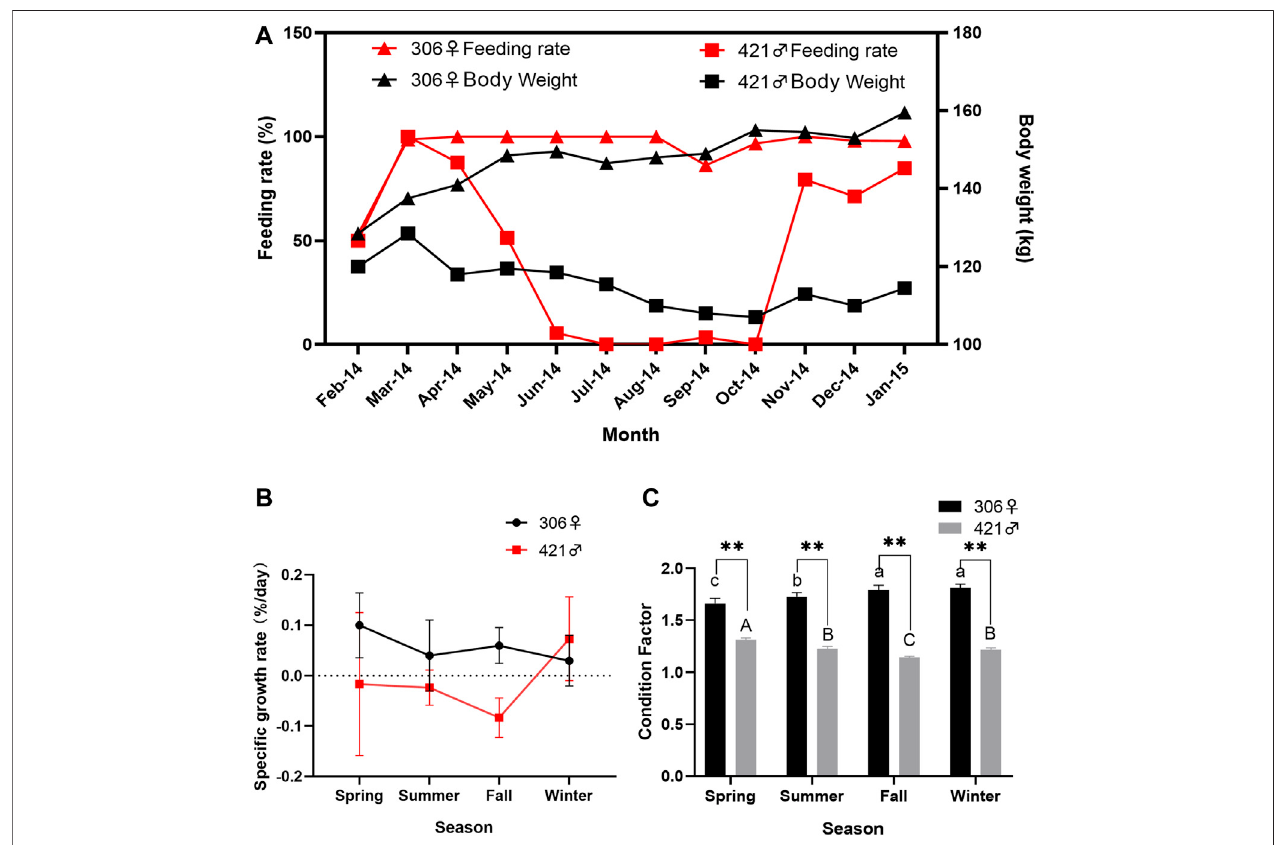
FIGURE 1 | Monthly changes of (A) body weight and feeding rate, and seasonal variation of (B) speci fi c growth rate and (C) Condition Factor of two Chinese sturgeons over the study period. Seasonal data are mean ± SEM ( n = 3), the seasonal data of sample size ( n = 3) represents the three monthly data within one season. Highly signi fi cant difference ( p < 0.01) in the parameter between the male and female individuals in the same season is denoted by two asterisks. Different uppercase letters indicate statistically signi fi cant differences between the male Chinese sturgeon in different seasons ( p < 0.05), whereas different lowercase letters indicate statistically signi fi cant differences of the female Chinese sturgeon in different seasons ( p < 0.05). Dashed line represents zero value.